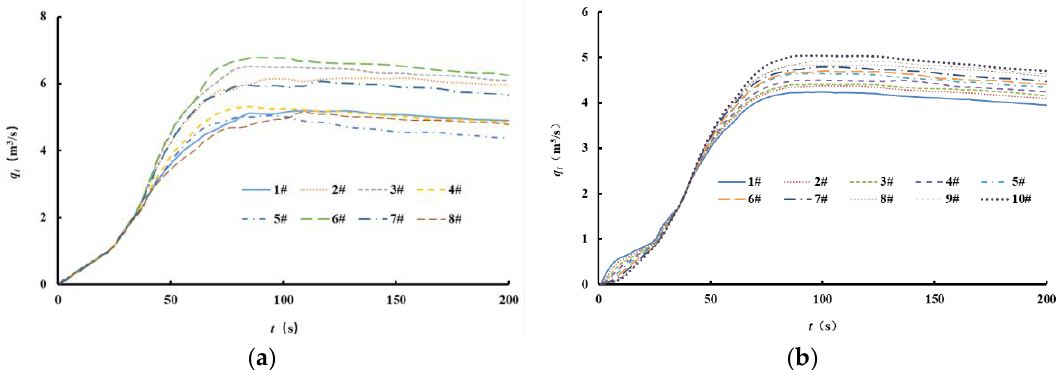
Figure 15. The change process of each branch outlet flow in the filling–emptying system under the condition of a 150 m lifting height: ( a ) the diagram of an equal inertial pipeline and ( b ) the longitudinal culvert.